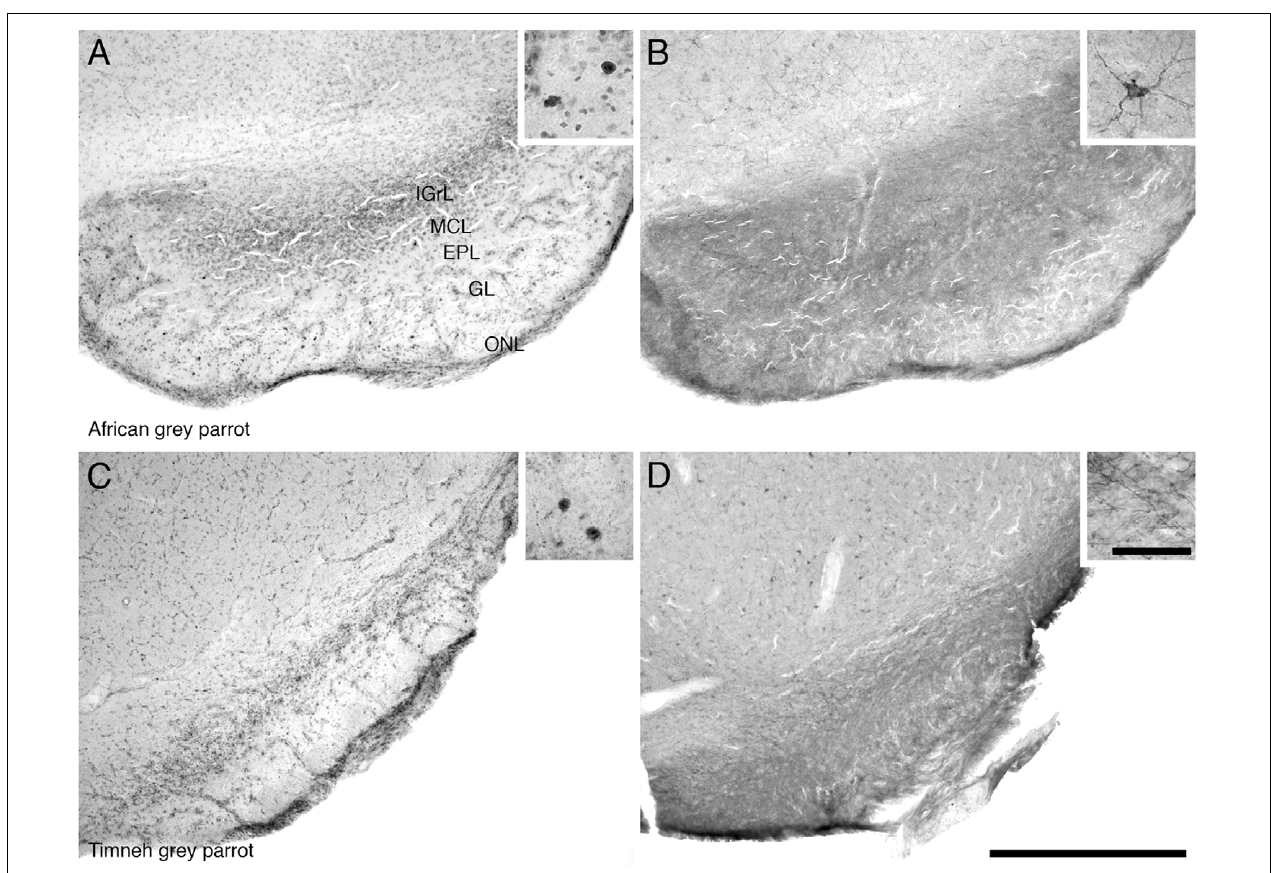
FIGURE 3 | Photomicrographs of PCNA – (A,C) and DCX (B,D) – immunostained coronal sections through the olfactory bulb (OB) of the two parrot species – (A,B) – African grey parrot ( Psittacus erithacus ), (C,D) – Timneh grey parrot ( Psittacus timneh ). In all images dorsal is to the top and medial to the right. (A,C) PCNA immunoreactivity revealed a high number of PCNA-immunoreactive cells in the IGrL, MCL, and EPL layers of the olfactory bulb. Insets in (A,C) show a higher magnification images of PCNA immunoreactive cells. (B,D) DCX immunoreactivity revealed a high density of DCX-immunoreactive cells and fibers in all layers of the olfactory bulb (IGrL, MCL, EPL, and GL) except the olfactory nerve layer. Insets in (B,D) show a higher magnification of DCX immunoreactive cells and fibers. All high power images on inserts were taken from consecutive sections to low power images. Scale bar in (D) = 500 µ m and applies to all. The scale bar in the inset in (D) = 50 µ m and applies to all insets. See list for